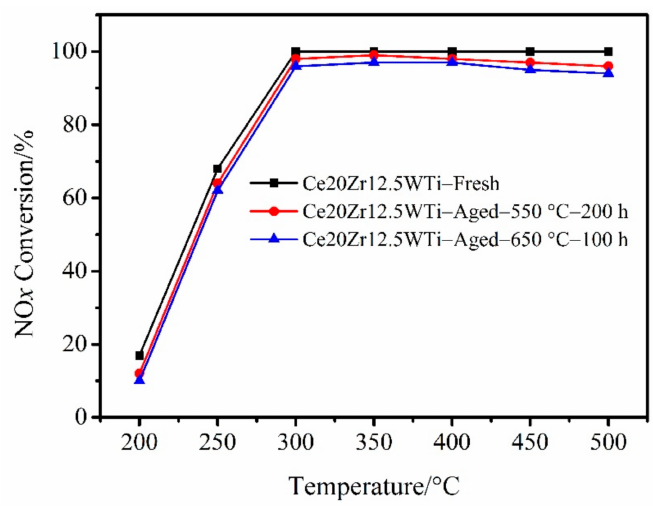
Figure 2. NO x conversion of fresh and aged Ce20Zr12.5WTi catalyst.